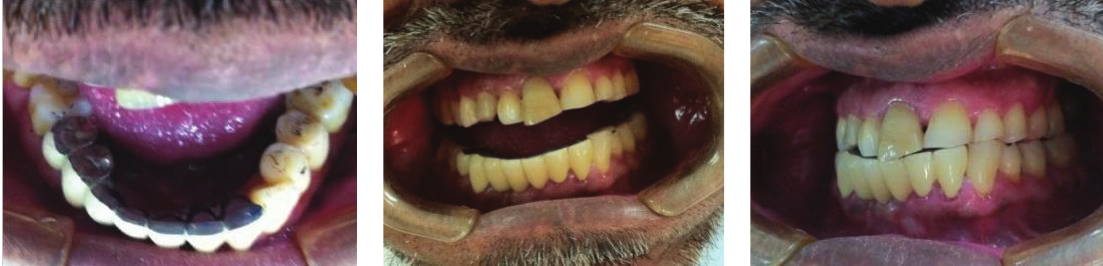
Figure 7: Definitive prosthesis after metal try-in and cemented FPD with metal occlusal